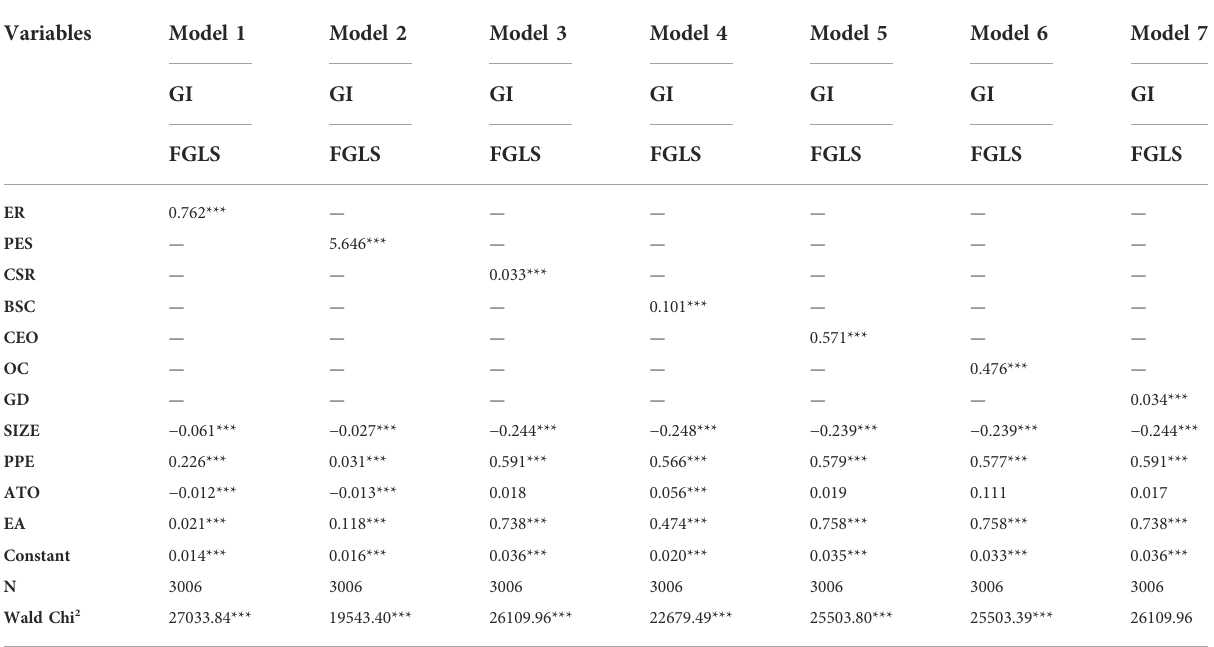
TABLE 6 Robustness test.